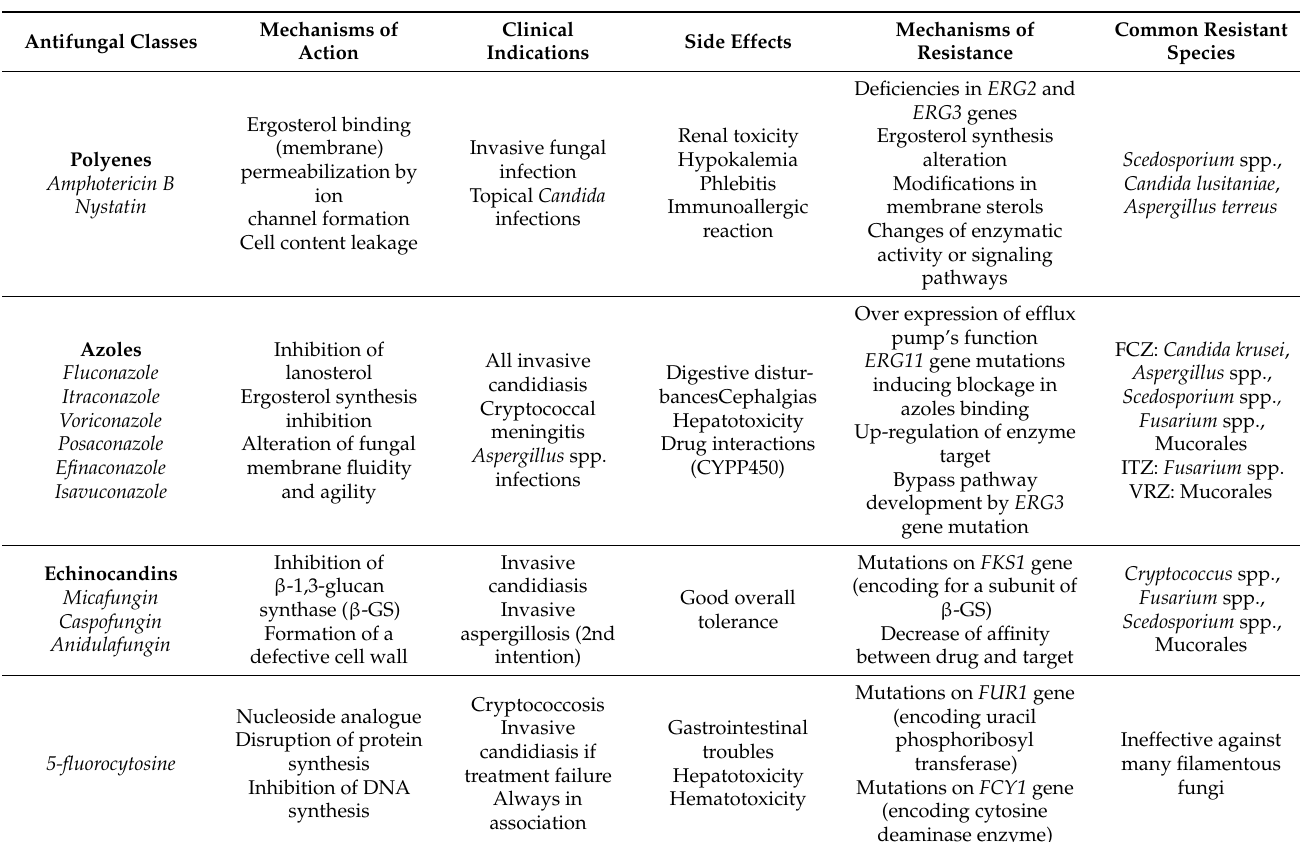
Table 1. Current main antifungal agents: mechanisms of action, clinical indications, side effects and mechanisms of antifungal resistance. FCZ: fluconazole, ITZ: itraconazole, VRZ: